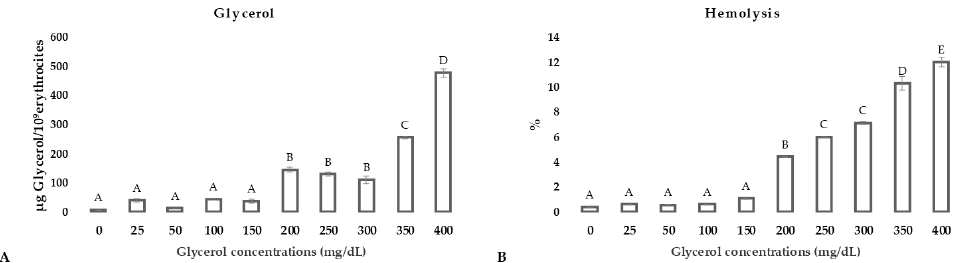
Figure 2. Intracellular glycerol concentrations after RBC incubation in media supplemented with glycerol in concentrations glycerol in concentrations ranging from 0 to 400 mg/dL ( panel A ); Hemolysis (%) after RBC incuba- ranging from 0 to 400 mg/dL ( panel A ); Hemolysis (%) after RBC incubation in media supplemented with glycerol in concen- tion in media supplemented with glycerol in concentrations ranging from 0 to 400 mg/dL ( panel B trations ranging from 0 to 400 mg/dL ( panel B ). Uppercase letters indicate significant differences between groups ( p < 0.001; one-way ANOVA–Tukey post hoc test).